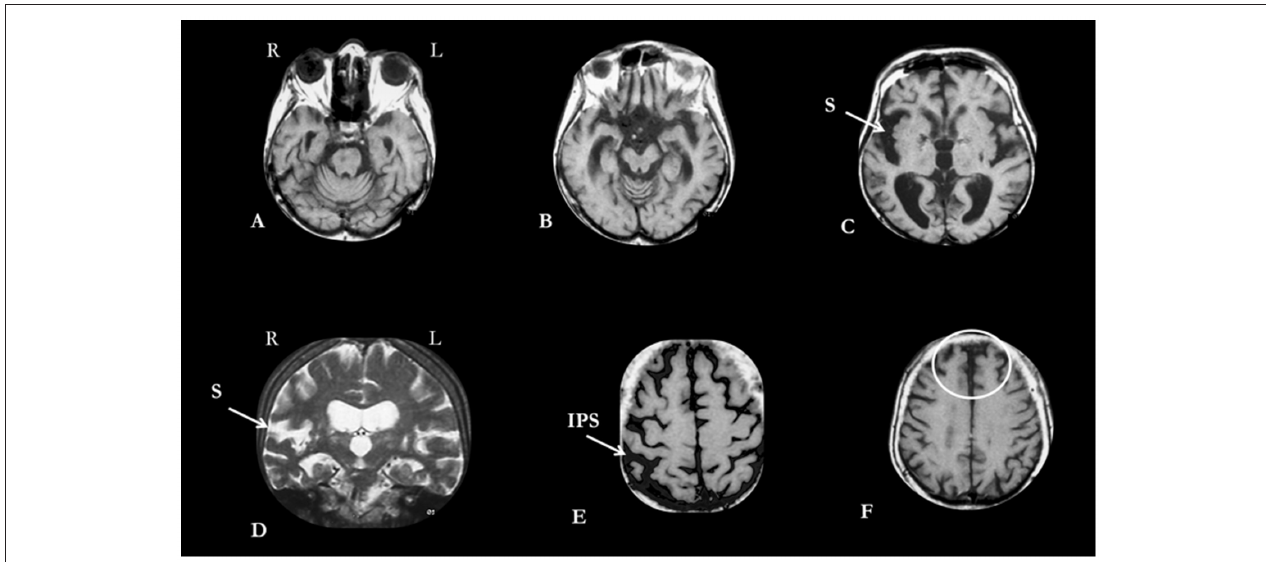
FIGURE 2 | MRI of patient obtained during the stage of catatonic stupor. (A,B) Vermal atrophy, and volumetric reduction of right side of ventral pons (A) and cerebral peduncle (B) . (C,D) Enlargement of sylvian fissures (S), more pronounced on the right, is evident on both axial (C) and coronal (D) planes. (E) Enlargement of intraparietal sulci (IPS), more pronounced on the right. (F) More evident atrophy of polar and superomedial prefrontal lobes (circled in white) in relation to the posteromedial parietal lobes. L, left; R, right.